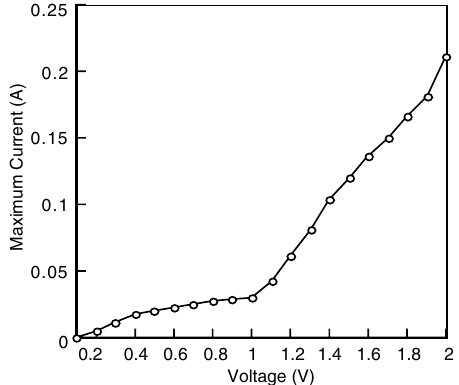
Figure 10 Maximum electric current (in